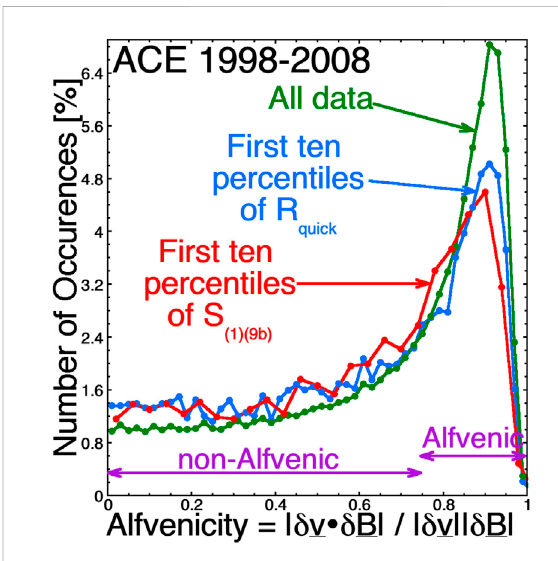
FIGURE 6 Occurrence distributions of the Alfvénicity |A| are plotted for all times (green), for times when the value of R quick is in the lowest 10% of its values (blue), and for time when the value of S (1)(9a) is in the lowest 10% of its values.